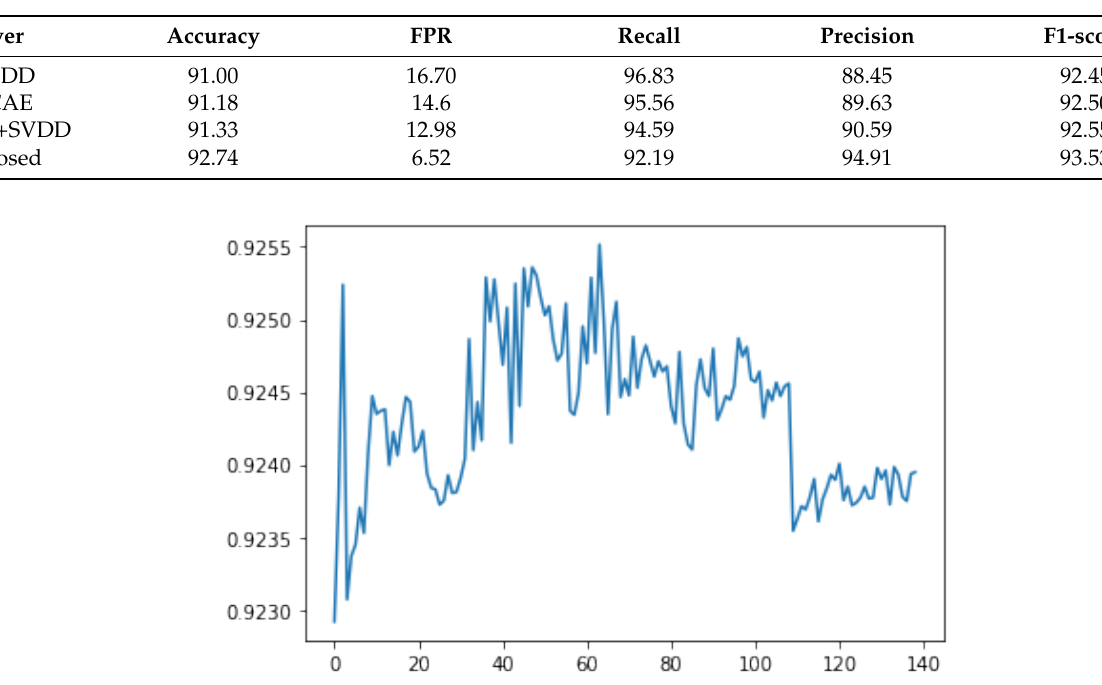
Table 3. Ablation analysis on NSL-KDD for different variants.